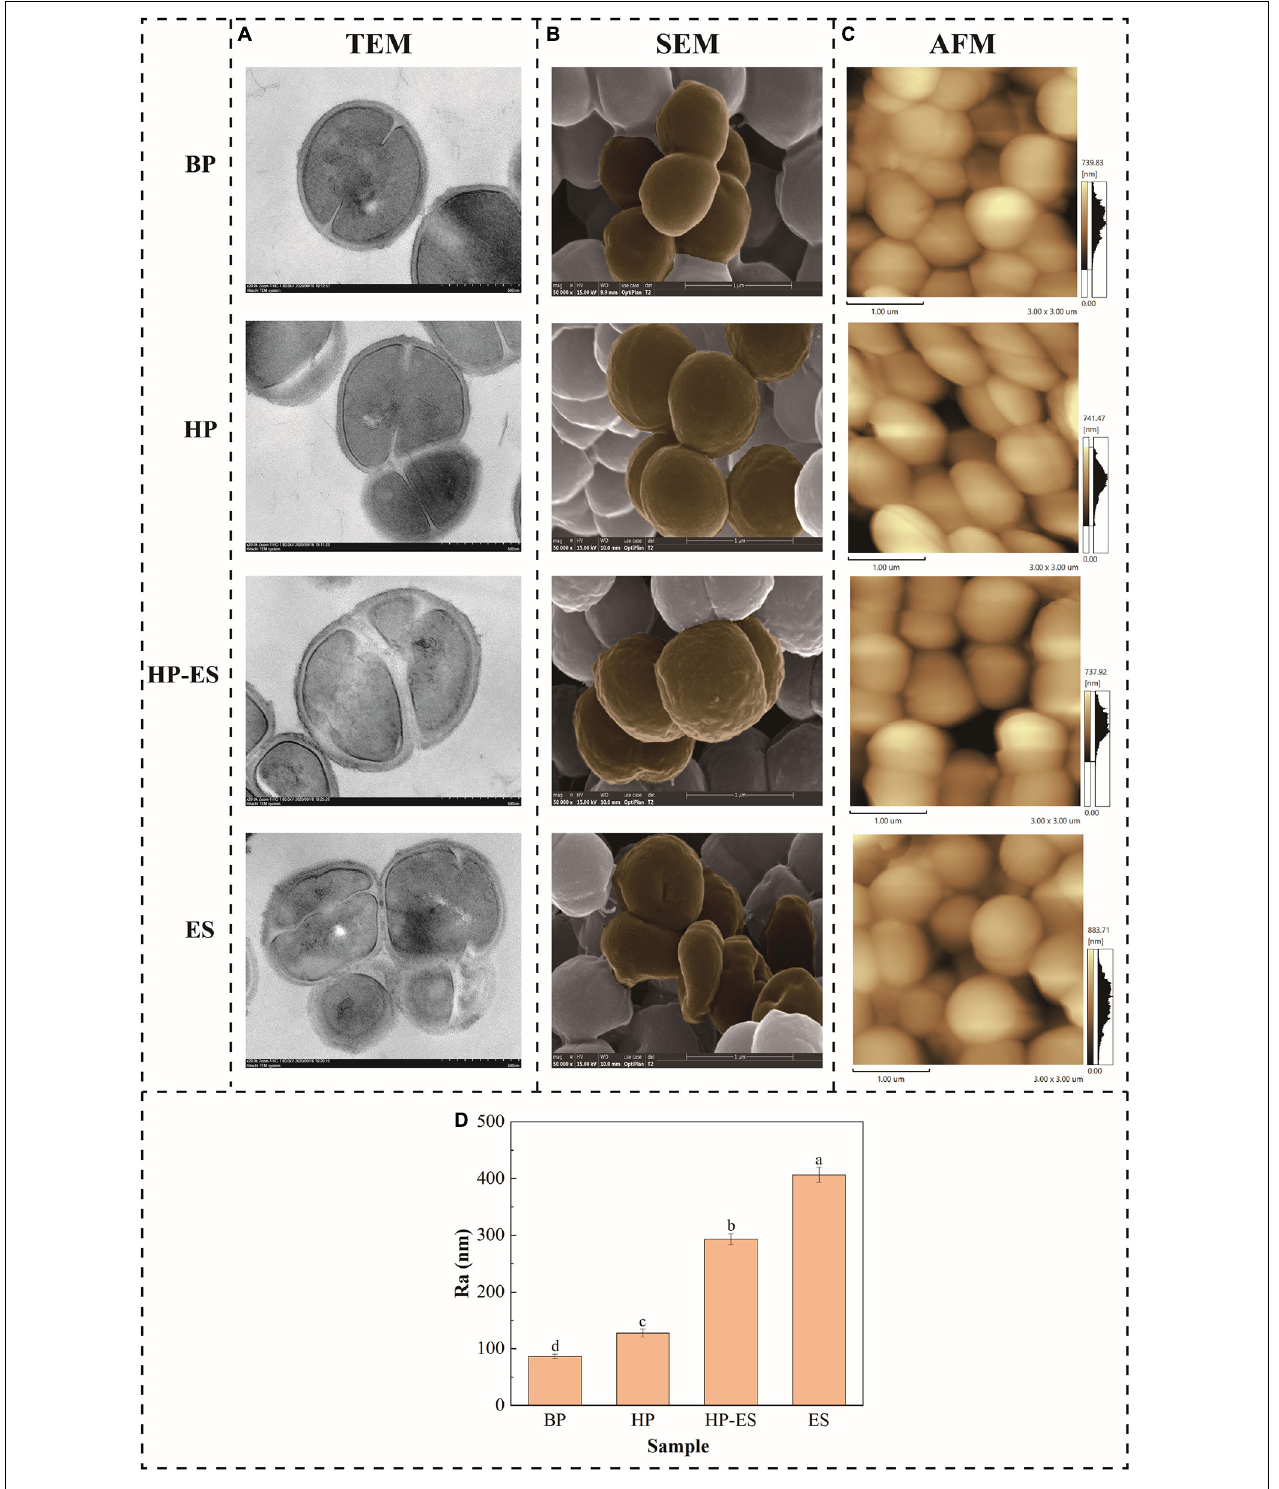
FIGURE 2 | Changes in membrane integrity (A) , cell morphology (B) , and membrane roughness average (C,D) of T. halophilus . BP (before preadaptation): cells harvested at mid-exponential growth phase without any treatment; HP (heat preadaptation): cells were collected after heat preadaptation at 45 ◦ C for 1.5 h; HP-ES (heat preadaptation-ethanol stress): cells were heat preadapted at 45 ◦ C for 1.5 h and then challenged by 10% ethanol stress for 2.5 h; ES (ethanol stress): cells subjected to 10% ethanol stress for 2.5 h without heat preadaptation. The brown parts were added to show rough and broken parts. Error bars indicate SD ( n = 3). Significant differences among the groups are marked with different letters ( p <